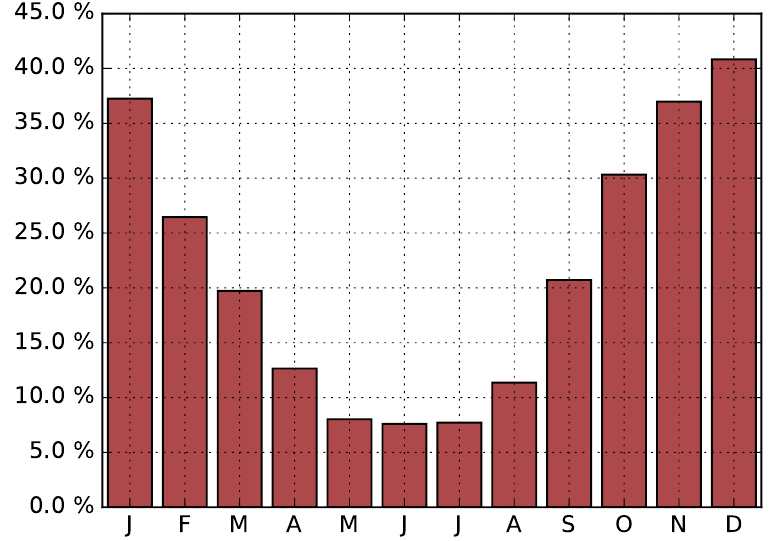
Figure 7. Percentage of winds of over 10 ms − 1 in each month. Based on Utö measurements from years